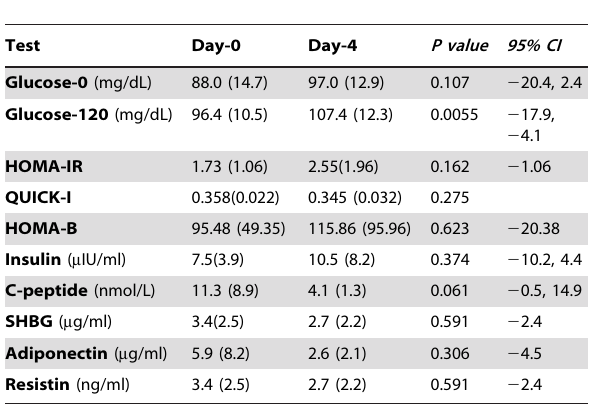
Table 8. Effects of Prednisone on glucose homeostasis, insulin resistance and secretion.